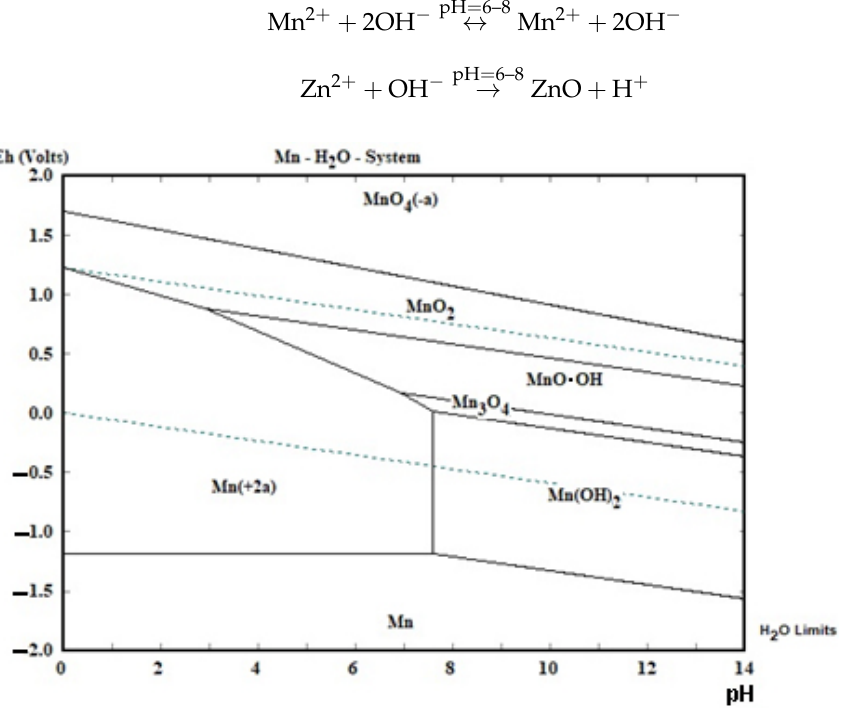
Figure 3. The potential—pH diagram for Mn-H 2 O system at 25 °C and 1 bar for molality 1 mol ∙ kg − 1 H 2 O [33].